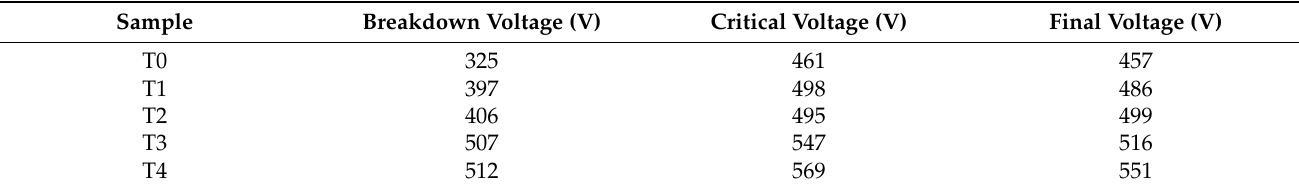
Table 3. The results of the voltage–time